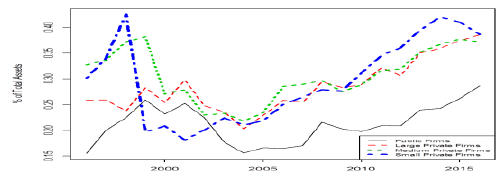
Figure 3. Non-Financial Sector Foreign Currency Position Source: CBRT, 2018 From 2015 to 20185, value of U.S.